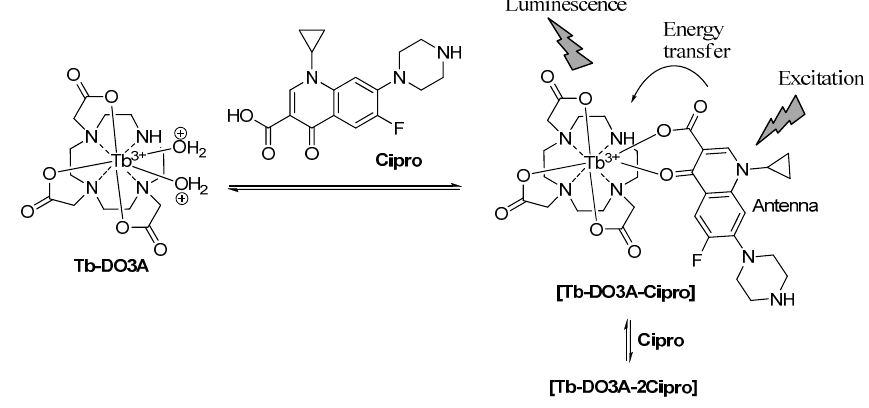
Figure 3. A sensing mechanism of Cipro with Tb-DO3A.